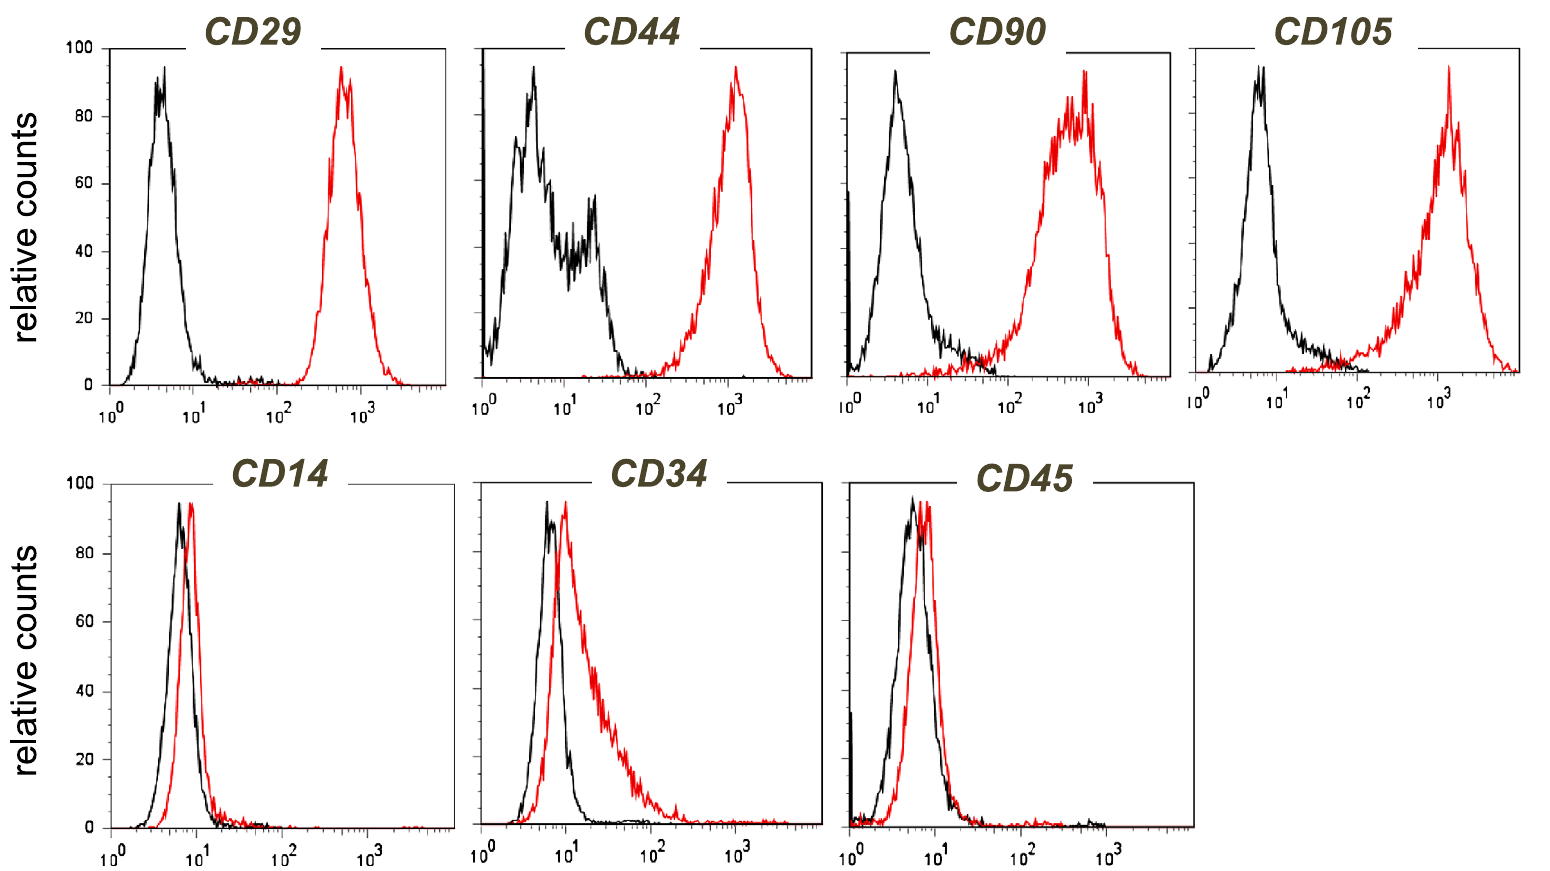
Fig. 1. hASCs express CD surface markers typical for mesenchymal stem cells. Flow cytometric analysis of CD surface markers on hASCs. Black histograms indicate isotype-matched controls; red histograms show surface antigen expression level. (The colors are visible in the online version of the